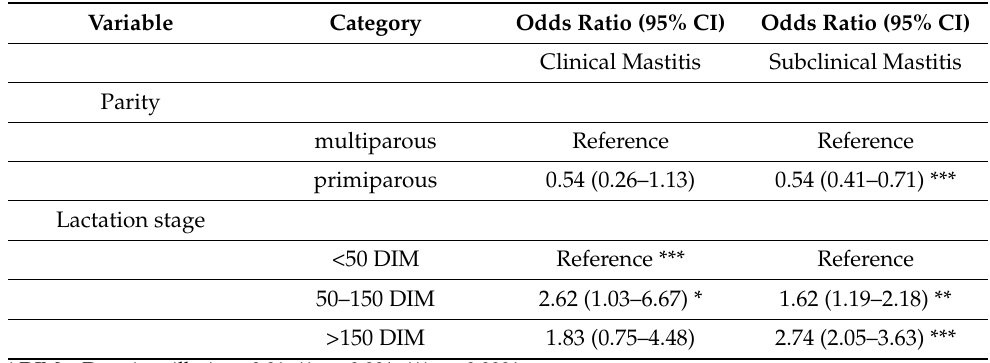
Table 2. Final multivariable logistic regression model of associations between cow level risk factors and clinical and subclinical mastitis at a quarter level in 10 smallholder dairy herds in Piracicaba Mesoregion, S ã o Paulo,